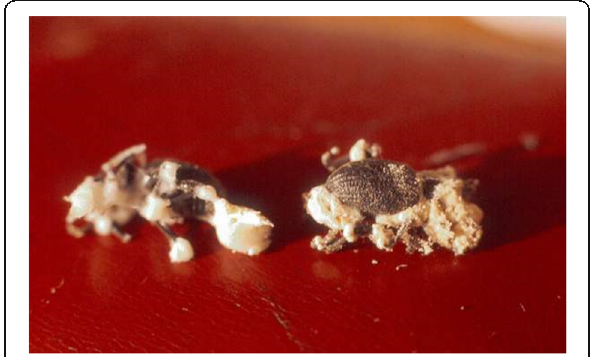
Fig. 3 Dead adults of H. brunneipennis (EAW) collected from under loose bark of eucalyptus trees post-spraying alfalfa with B. bassiana showing typical symptoms of death by “ white muscardine ”